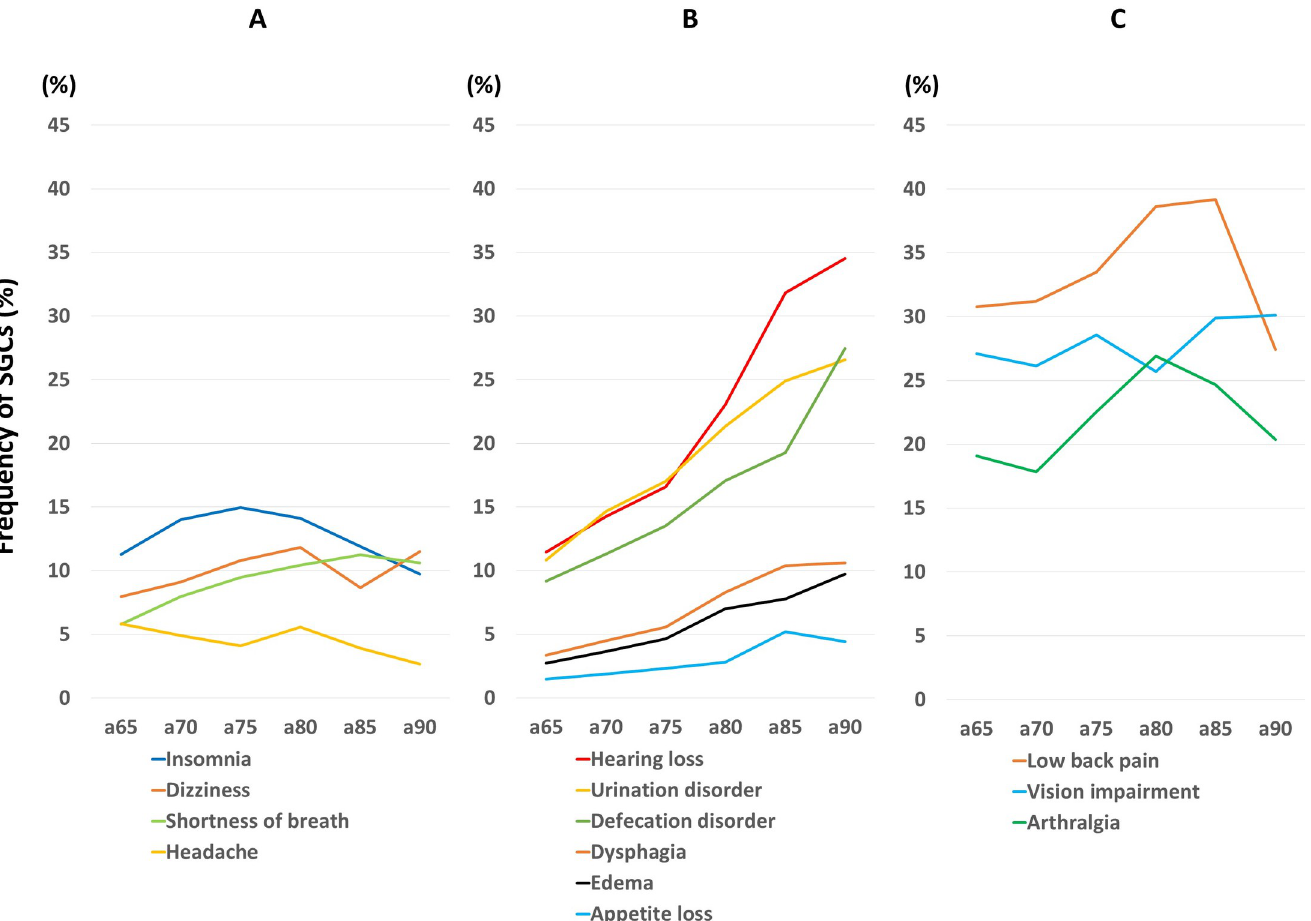
other SGCs (defecation disorder, urination disorder, and hearing impairment) showed a relatively high frequency, with more than 15% in all age groups, and steeply increased with age. (C) Three SGCs were frequent in all age groups, with rates of 15% or more in each. The horizontal axis indicates the age group. Each 5-year age group is shown with ‘a’ plus youngest age in the group, e.g., a65 means the age group of 65–69